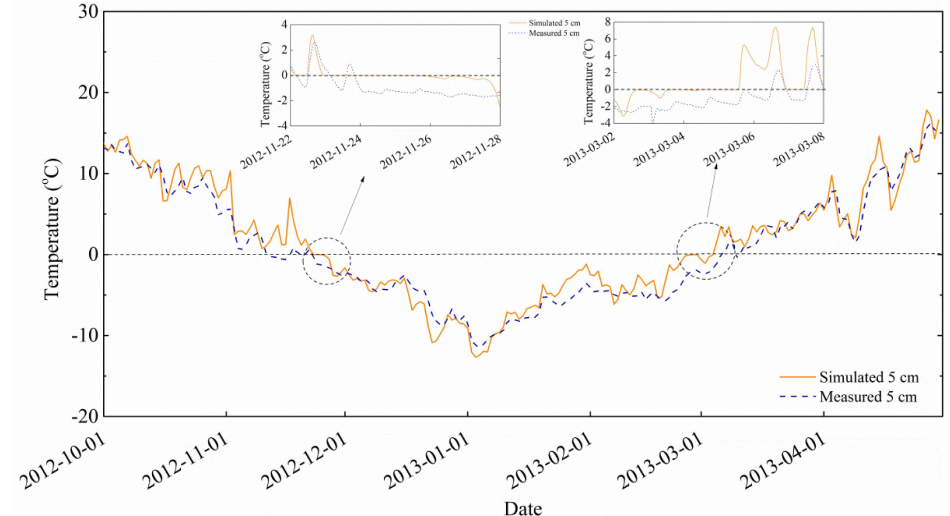
Figure 3. Comparison of modeled freezing point with measured freezing point at 5 cm depth. The orange line denotes simulated soil temperature and the blue dashed line is the measured soil temperature at 5 cm depth.